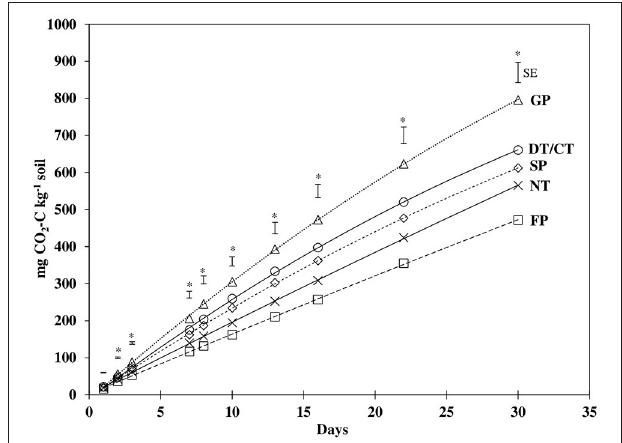
FIGURE 1 | Carbon mineralization from soils under grass pasture (GP), no-till (NT), disk/chisel tillage (DT/CT), spring plow (SP), and fall plow (FP) in 30 days of incubation. Error bars are standard error (SE) values of least square mean differences for individual days. *Indicates significant ( P ≤ 0.05) treatment differences for that